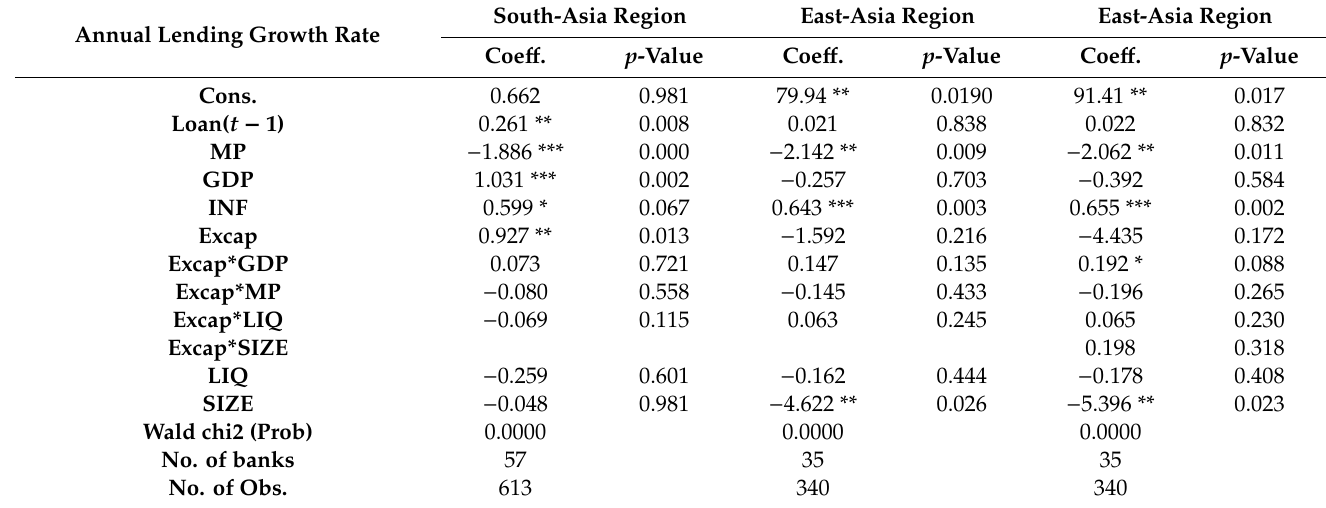
Table A3. Main Model